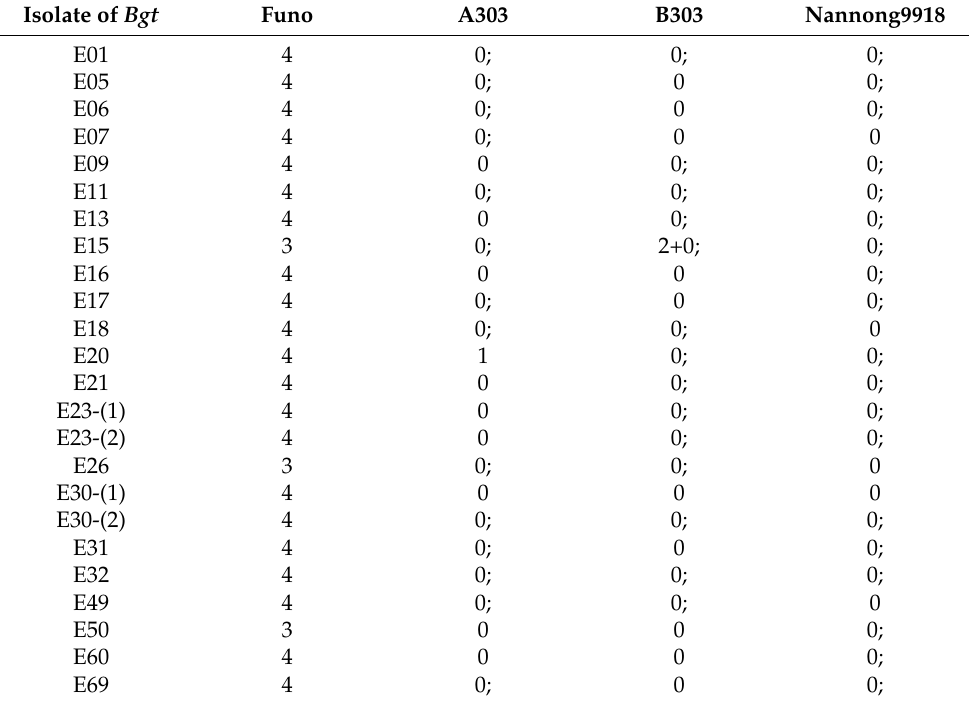
Table 3. Reactions of translocation lines to 24 different individual Bgt strains.